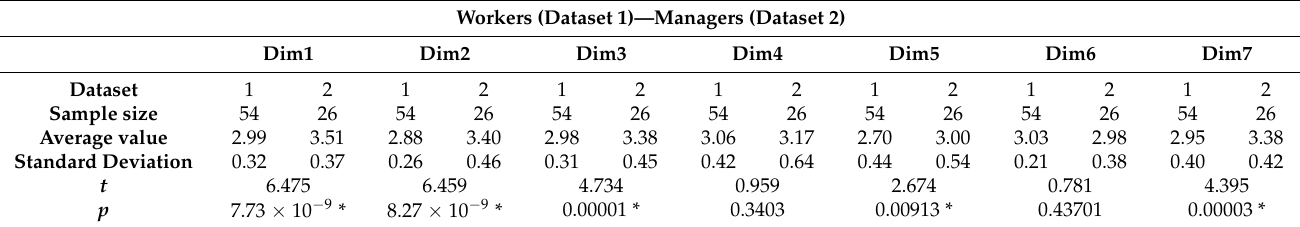
Table 10. Results of the t -test analyses related to the correlation worker–manager in the NOSACQ-50 questionnaire 1